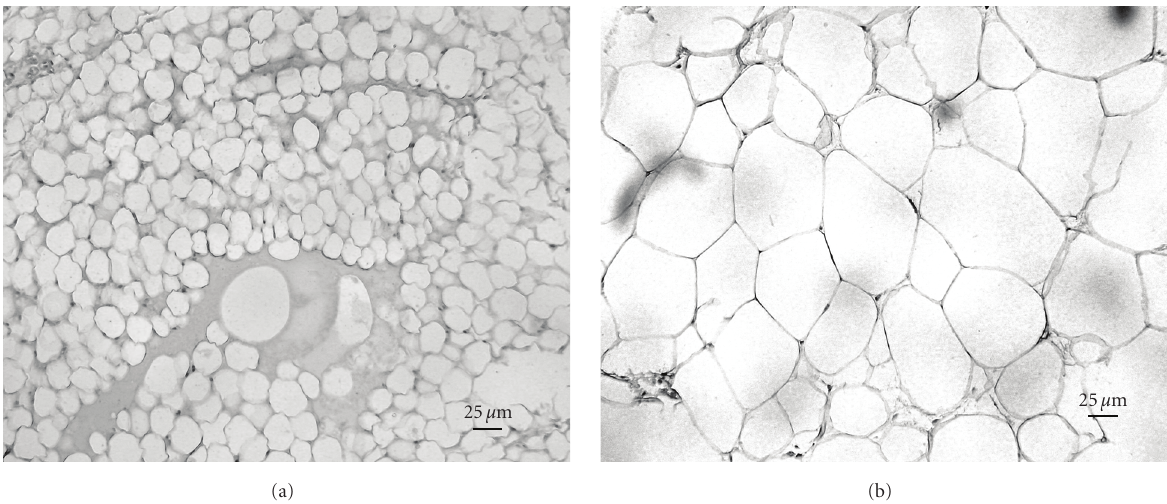
Figure 1: Histomorphological picture of adipose tissue in a cachectic (a) and obese (b) patient with chronic obstructive pulmonary disease ( × 200 magnification).